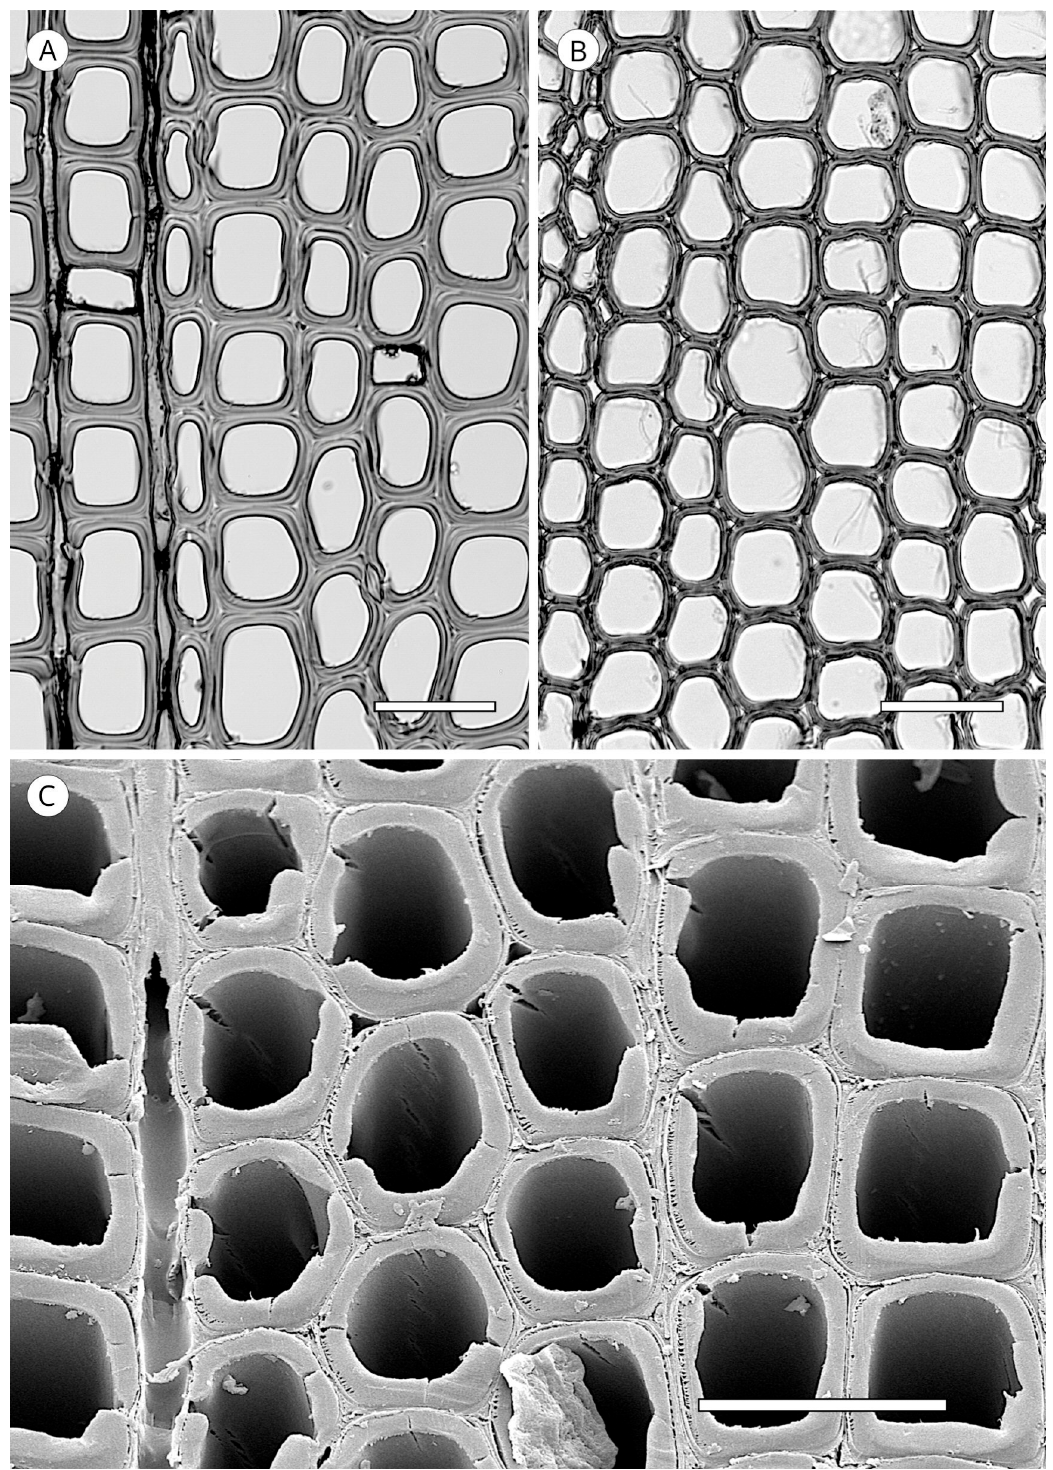
Figure 10. Intercellular spaces. ( A ) Agathis alba (Rumph. ex Hassk.) Foxw.; ( B ) Pilgerodendron uviferum (D.Don); ( C ) Intercellular spaces and spiral grooves in compression wood in Taiwania cryptomerioides Hayata (SEM). Scale bars. ( A – C ) = 50 μ m. These longitudinal intercellular spaces are connected only with radial intercellular spaces [102]. Intercellular spaces are generally thought to have three functions: for gas exchange, as a conduit for storage of water and nutrients, and as a pathway for diffusing heartwood substances [103].